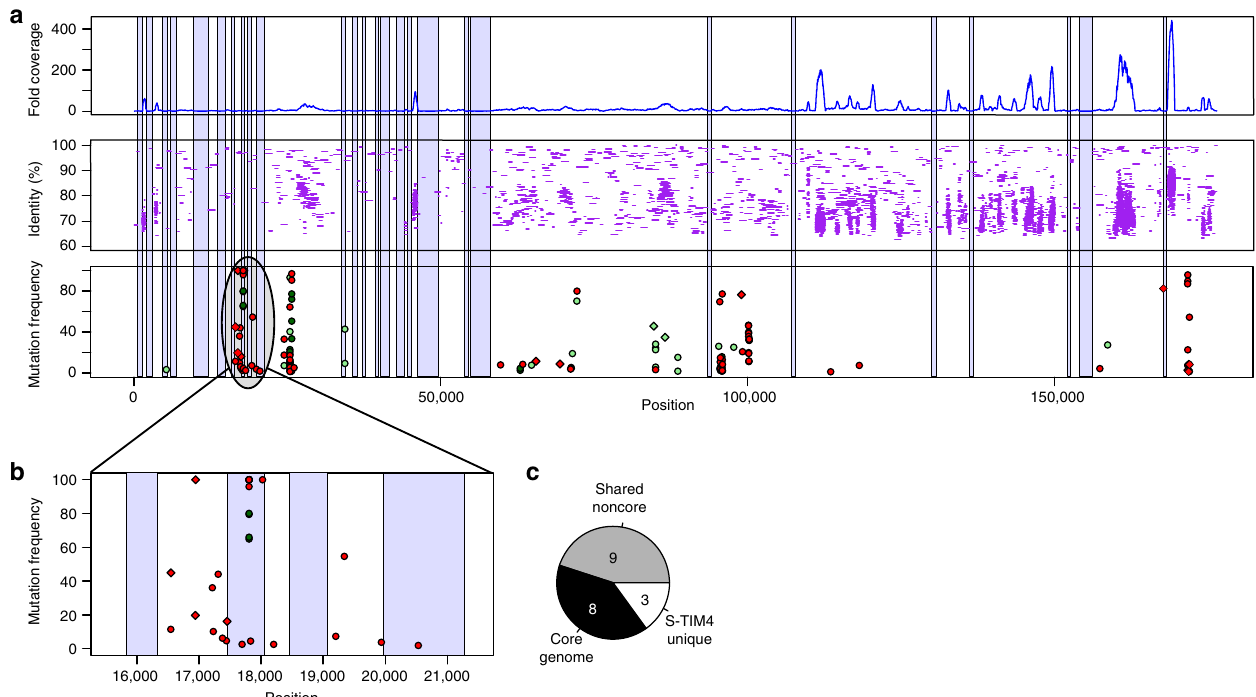
Fig. 5 Variable genomic regions are not enriched in mutations. a Mapping of metagenomic reads to the S-TIM4 genome reveals mutations in variable and conserved regions with no enrichment in either. The position along the genome is on the X -axis. The lower panel shows mutation frequencies for phage populations along the genome. Colors denote the type of host the viral population evolved in: MIT9515 (dark green), MED4 (light green), and WH8102 (red). The middle panel shows the mapping of metagenomic reads to the S-TIM4 genome with the percent nucleotide identity of each read to the viral genome. The upper panel shows the fold-coverage of the metagenomic reads along the genome. Hypervariable genomic regions are shaded in purple (i.e. >500 bp long, coverage lower than 20% of mean). b Zoomed-in view of a mutation-rich genomic region (positions 15,500 – 21,500, open reading frames 23 – 27) of the S-TIM4 genome. c Adaptation of S-TIM4 to hosts occurs mostly by mutations in genes found in other cyanomyophages. Genes are classi fi ed as unique in S-TIM4 (have no close homologs in other phages), belonging to the cyanomyophage core genome (present in all studied cyanomyophage genomes), or shared noncore (appear in some cyanomyophage genomes). Raw data can be found in Supplementary Tables 2,